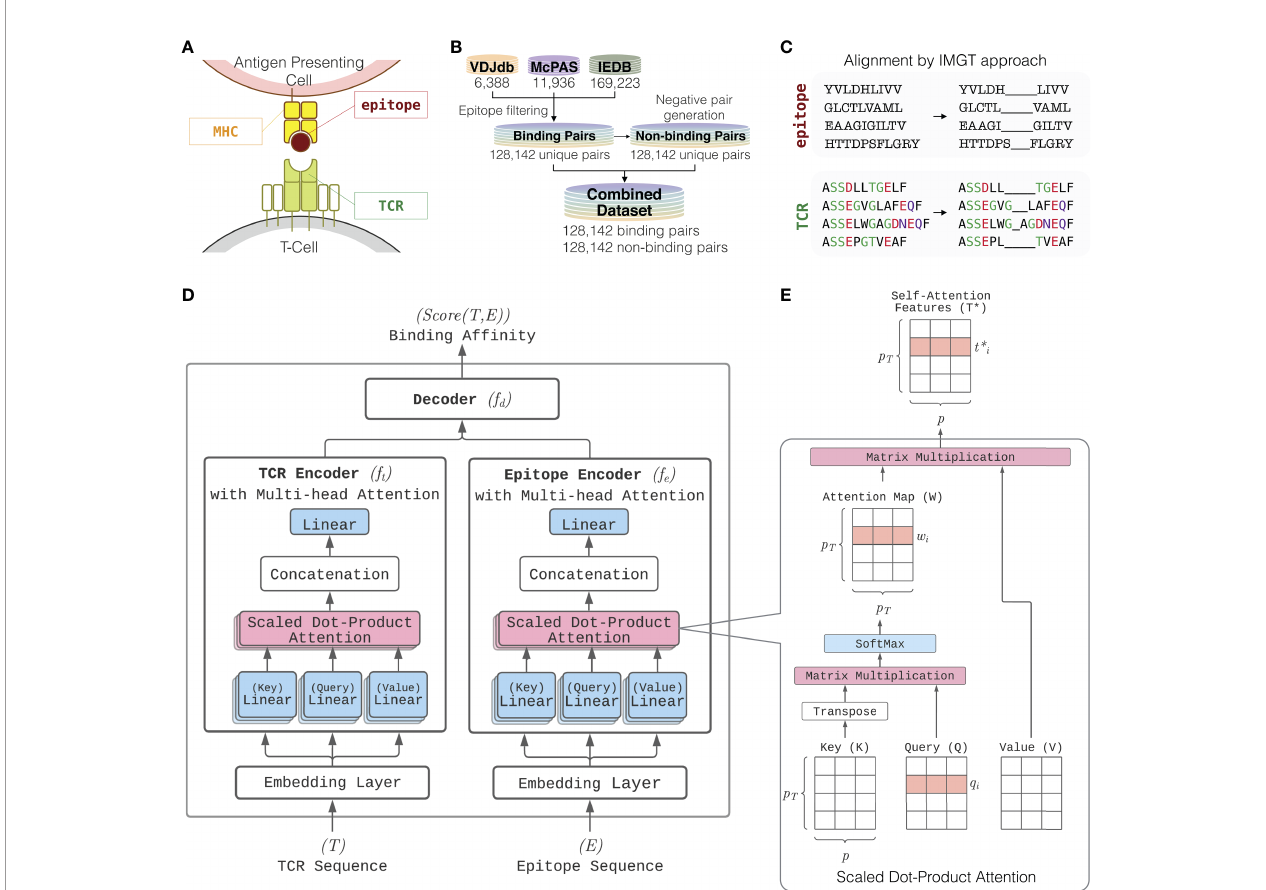
FIGURE 1 | Overview of ATM-TCR. (A) T-cell epitope recognition. The T-cell receptor (TCR) is a protein complex on the surface of a T-cell. It recognizes epitopes displayed by MHC complex on cell surface. (B) The training and testing datasets consist of TCR-epitope pairs known to bind collected from VDJdb, McPAS-TCR, and IEDB. The three databases are combined into a single dataset containing unique binding pairs. The same number of negative pairs is generated through random recombination. (C) Each of the TCR and epitope sequences are aligned via IMGT approach where the paddings are inserted into the middle of each sequence until its length reaches a pre-de fi ned value. (D) Model architecture of ATM-TCR. It takes a pair of TCR and epitope sequences as an input and predicts the binding af fi nity between the two. It consists of two parts where a TCR and epitope are processed separately. TCR and epitope are 20 and 22 amino acids long, respectively, including paddings in the middle. Each sequence is passed through a separate embedding layer which maps the sequence of one-hot amino acid vectors to a sequence of continuous feature vectors with the size 25. These features are then passed into a corresponding encoder. Each encoder makes use of the multi-head attention mechanism which allows fi ve self-attention layers are learned in parallel. Outputs of the fi ve self-attention layers are then concatenated and linearly transformed to obtain an encoded sequence representation. The encoded TCR and epitope sequences are then concatenated together and passed into a decoder with three linear layers of size 2048, 1024, and 2 which determines the fi nal binding af fi nity score between the two. (E) The multi-head attention layer makes use of multiple self-attention layers called scaled dot-product attention. It utilizes the input sequence for each of its three inputs: key (K), query (Q) and value (V). It uses a scaled dot-product between keys and queries to obtain an attention map relating different positions of the sequence. The attention map is then used to weight values and compute a new sequence representation, denoted as self-attention features